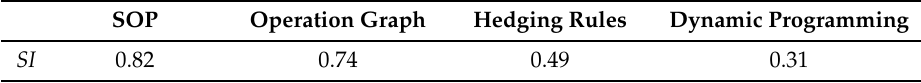
Table 2. Water deficit index of different schemes.